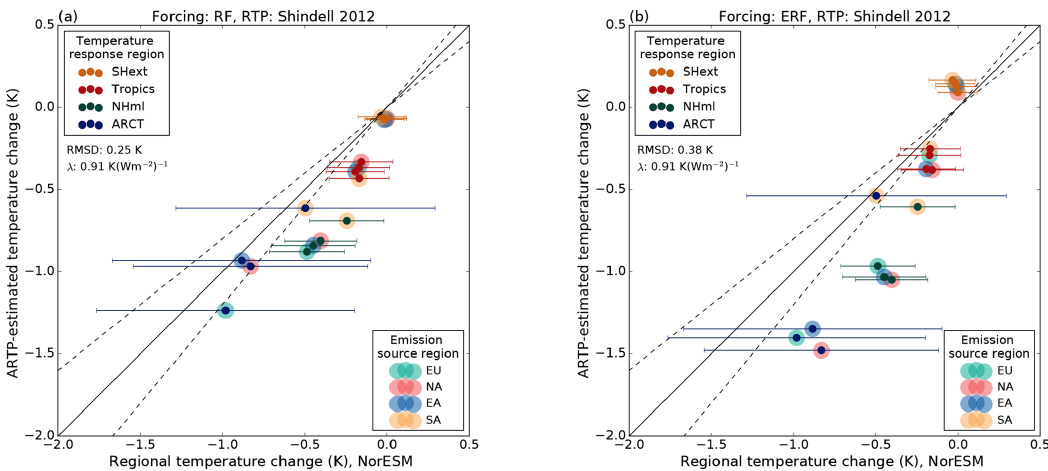
Figure 13. As Fig. 11 but with the RTP coefficients of Shindell (2012), Eq. (2) with the CO 2 sensitivity from Iversen et al. (2013).